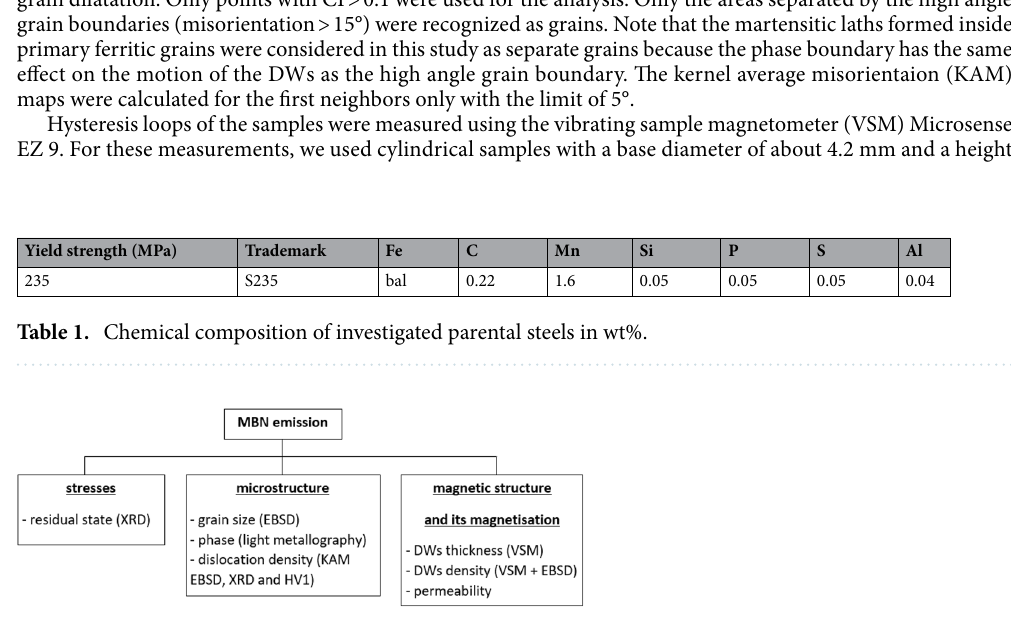
Figure 1. Brief list of aspects affecting MBN and experimental techniques employed for their